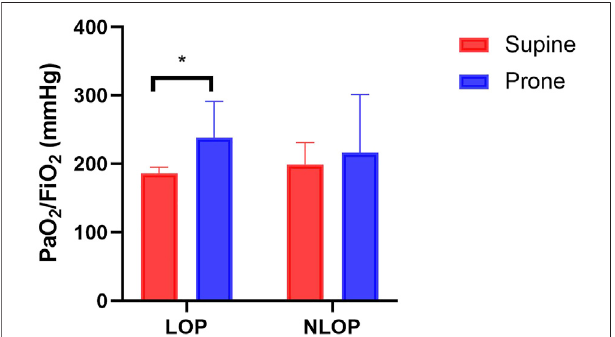
FIGURE 2 | Ratio between the arterial partial pressure of oxygen and fractionofinspiredoxygen(PaO 2 /FiO 2 )indifferentpositionsofthetwogroups. PaO 2 /FiO 2 in the LOP group was signi fi cantly increased during prone position compared with supine position. No signi fi cant difference was observed in the NLOP group. * p < 0.05 compared with supine position.